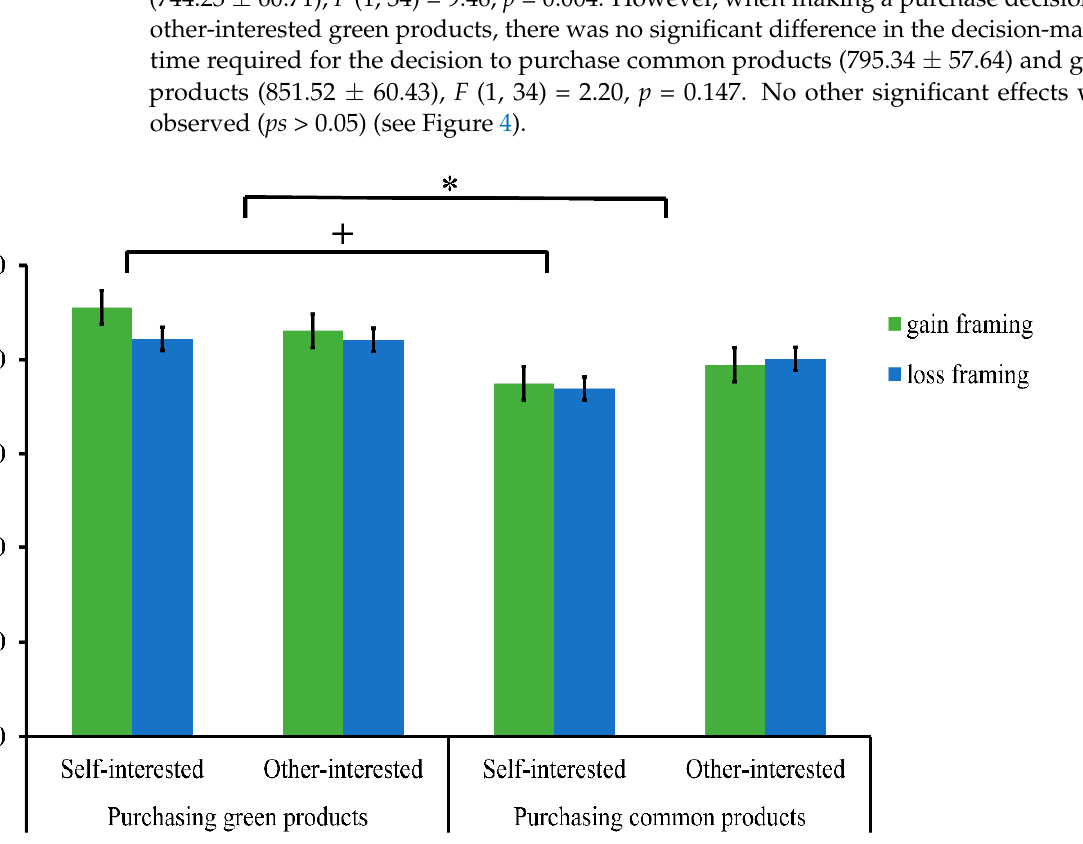
Figure 4. Bar graph of the decision time in each condition. * p < 0.05, + p < 0.10. Self-interested: self- interested green products, Other-interested: other-interested green products. self-interested green products, Other-interested: other-interested green